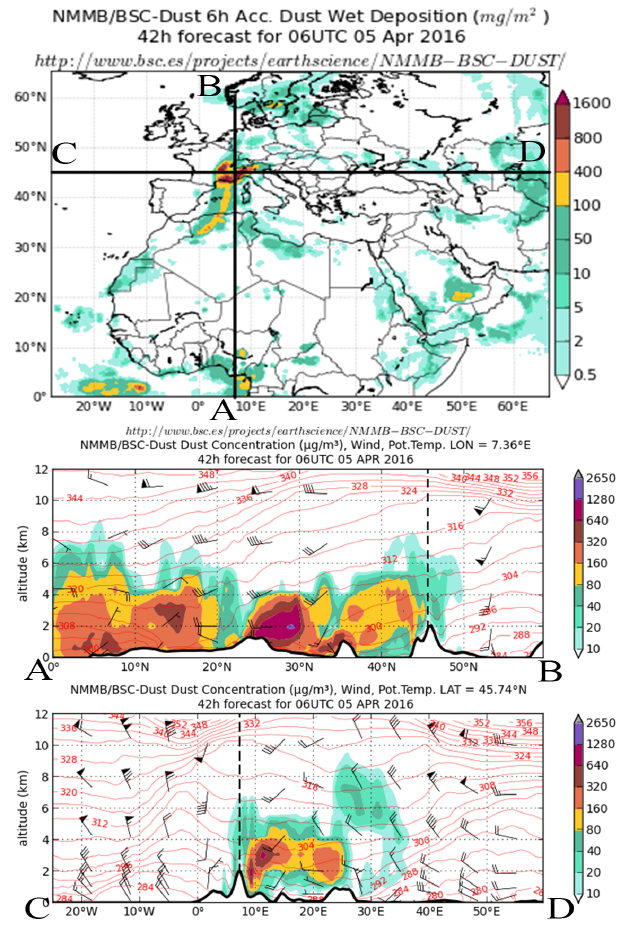
Figure 2. NMMB/BSC-Dust forecast for the event of April 2016. In the top panel is the estimated surface concentration by wet deposition. The lower panels represent, respectively, a latitudinal and longitudinal transect centred on the city of Aosta (45.74 ◦ N; 7.36 ◦ E). Images are from the NMMB/BSC-Dust model, operated by the Barcelona Supercomputing Center (http://www.bsc.es/ess/ bsc-dust-daily-forecast/, last access: 2 April